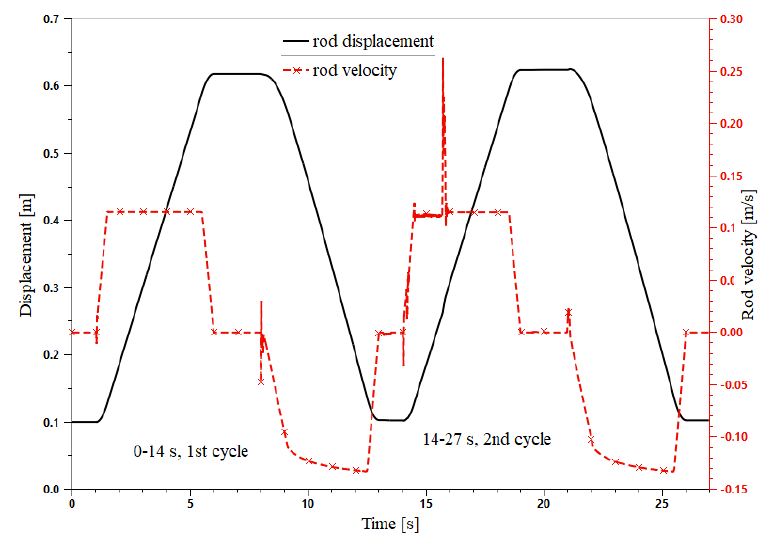
Figure 18. The boom cylinder rod velocity and displacement of the proposed system when the excavator bucket is fully loaded.